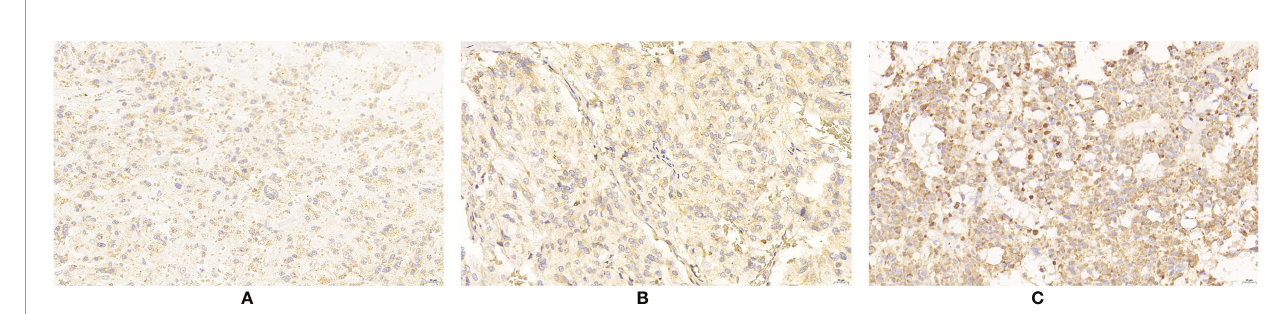
FIGURE 6 | Expression of ERBB-2 in PPGLs. (A) Weakly positive immunostaining of ERBB-2 in PPGLs. (B) Intermediately positive immunostaining of ERBB-2 in PPGLs. (C) Strongly positive immunostaining of ERBB-2 in